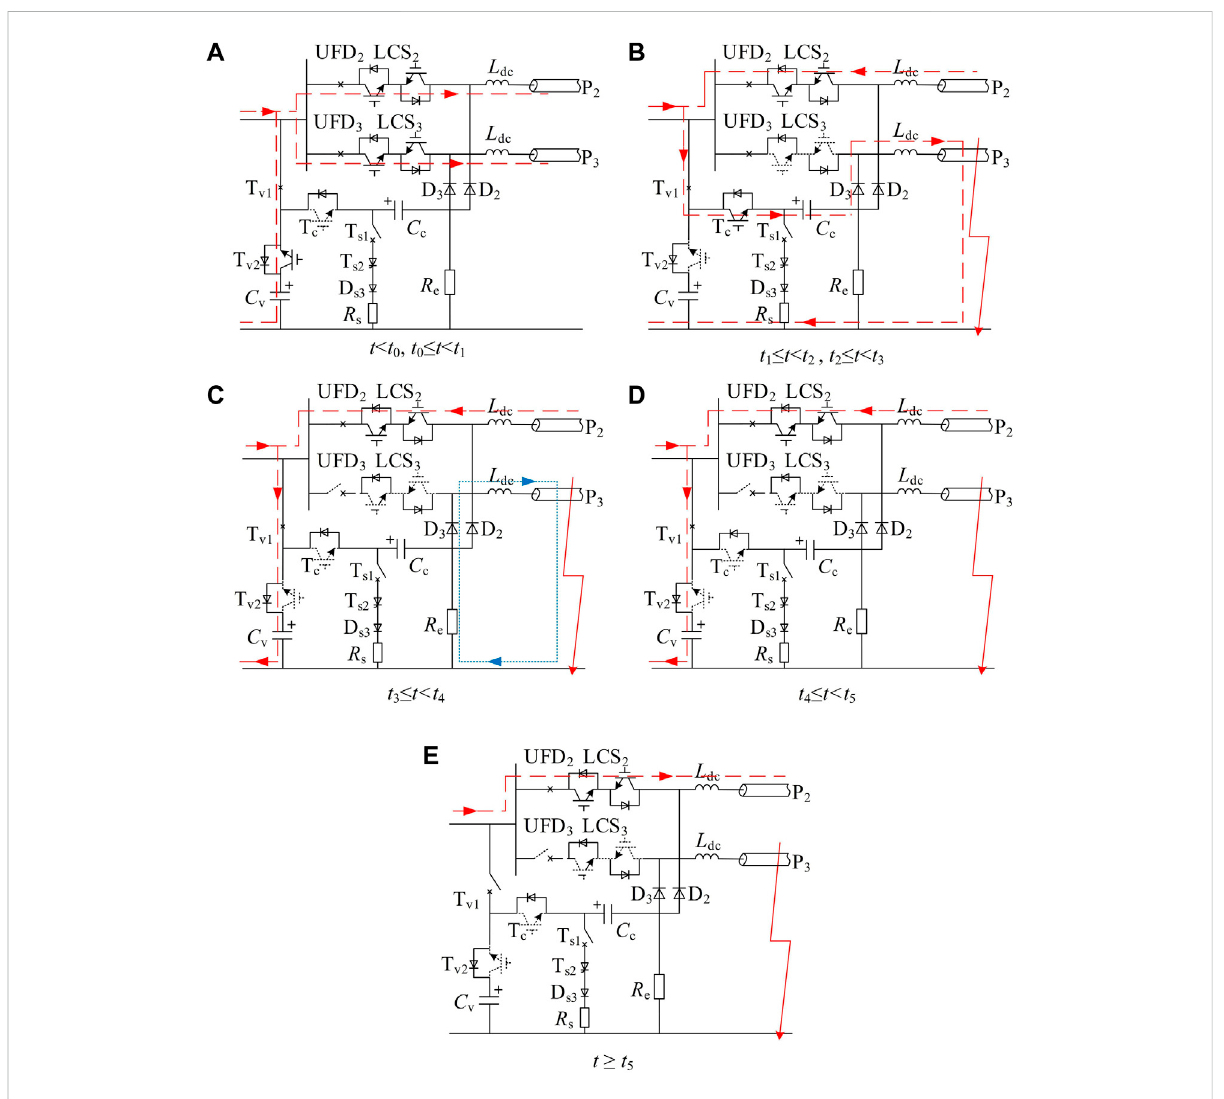
FIGURE 4 Fault Isolation Action